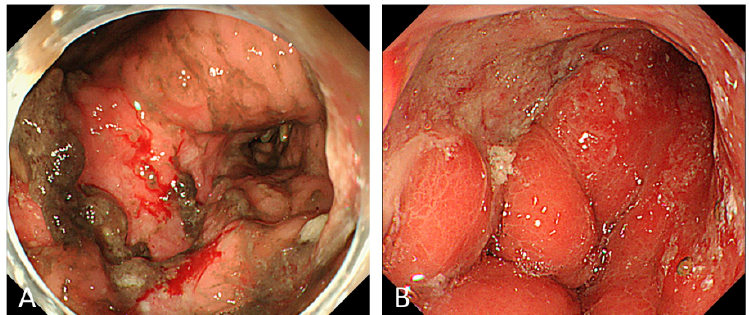
Figure 6. Palliative radiotherapy (PRT) for bleeding gastric cancer. PRT with 30 Gy in 10 fractions was applied to an easy-bleeding tumor at the anterior wall of angle ( A ). No bleeding event or anemia progression had been experienced by four months after starting PRT and ulceration of the tumor was confirmed endoscopically ( B ).